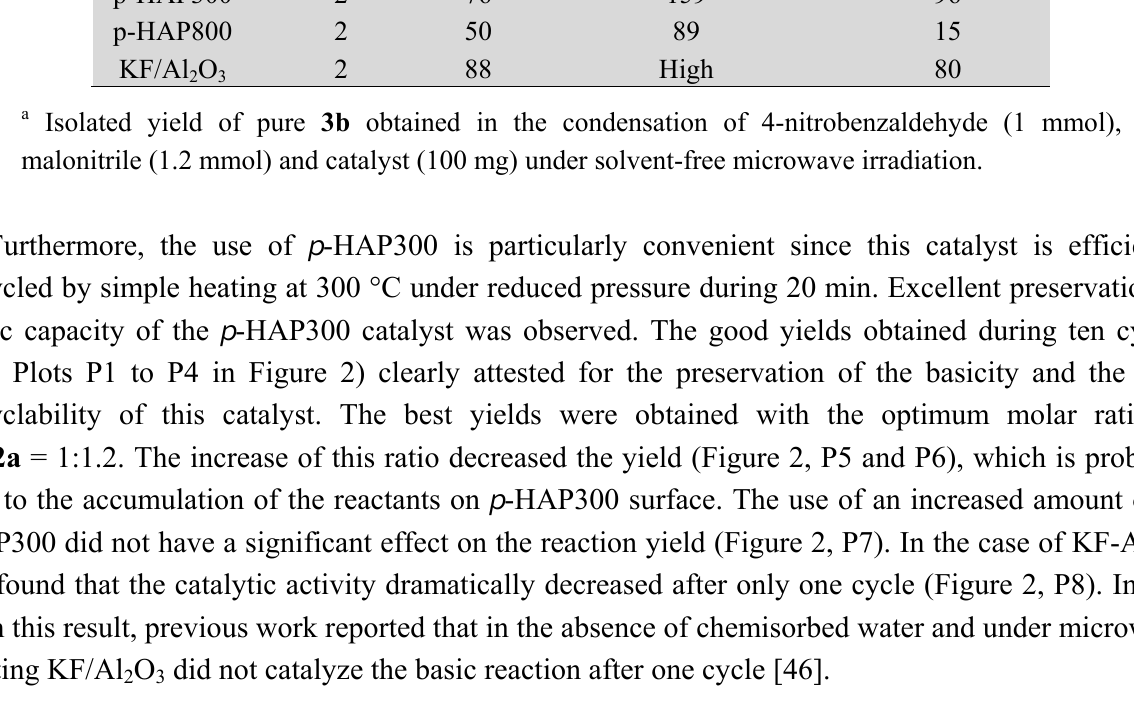
Figure 2. Recycling of the p -HAP300 catalyst for ten successive cycles and effect of molar ratio n( 1b) :n( 2a ) on the yield of Knoevenagel condensation affording 3b , under microwave